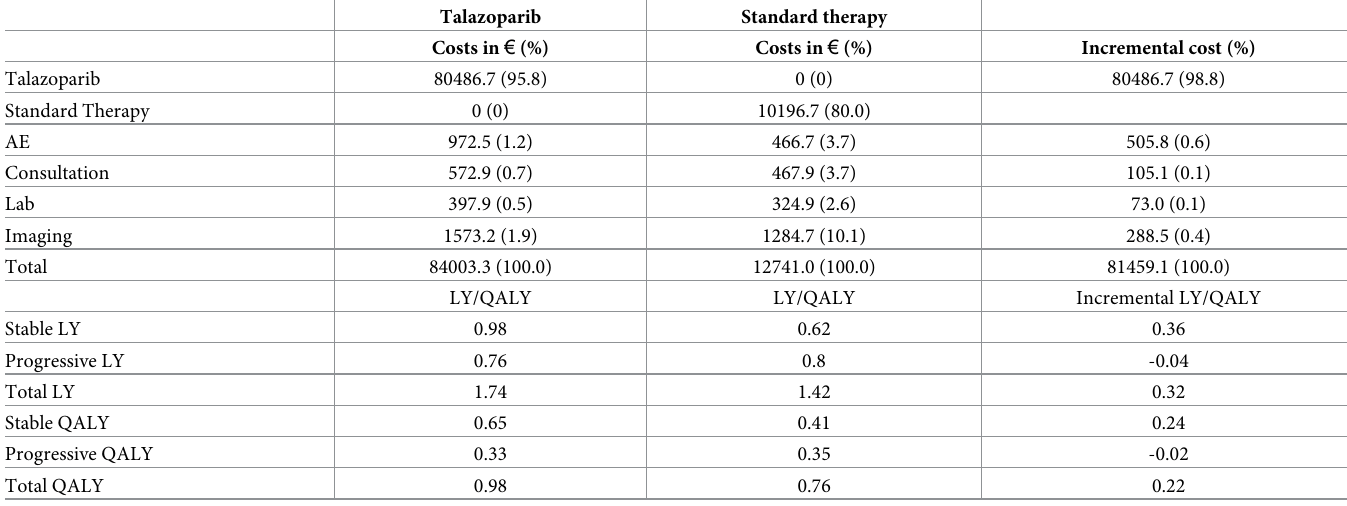
Table 2. Disaggregated outcomes (costs and utilities).